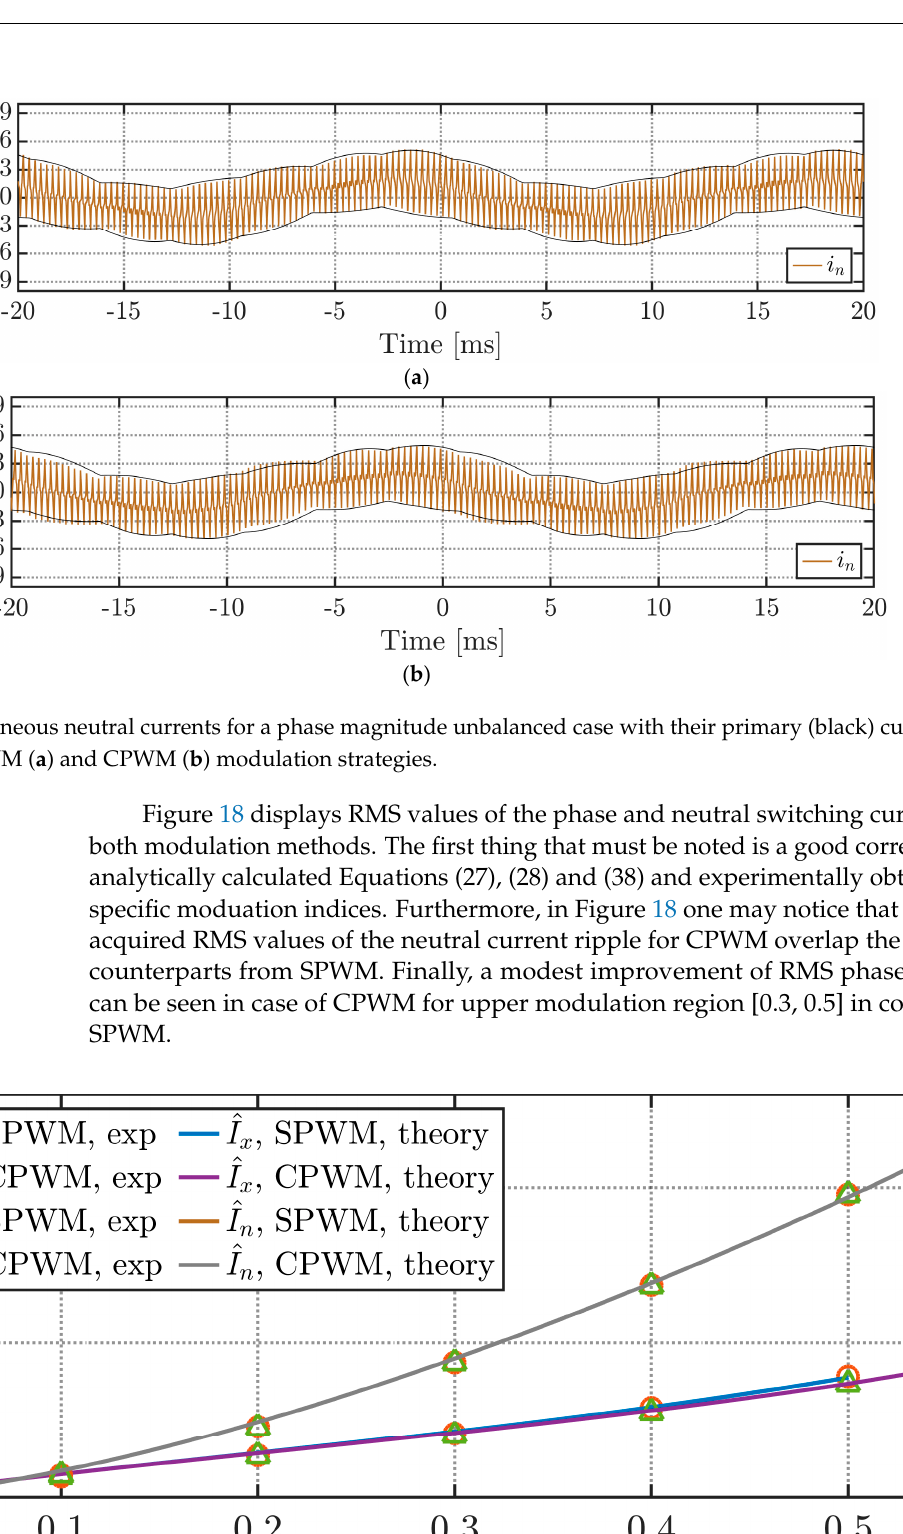
Figure 16. Instantaneous phase currents for a magnitude unbalanced case with their primary (black) and secondary (gray) current ripple envelopes for SPWM ( a ) and CPWM ( b ) modulation strategies.